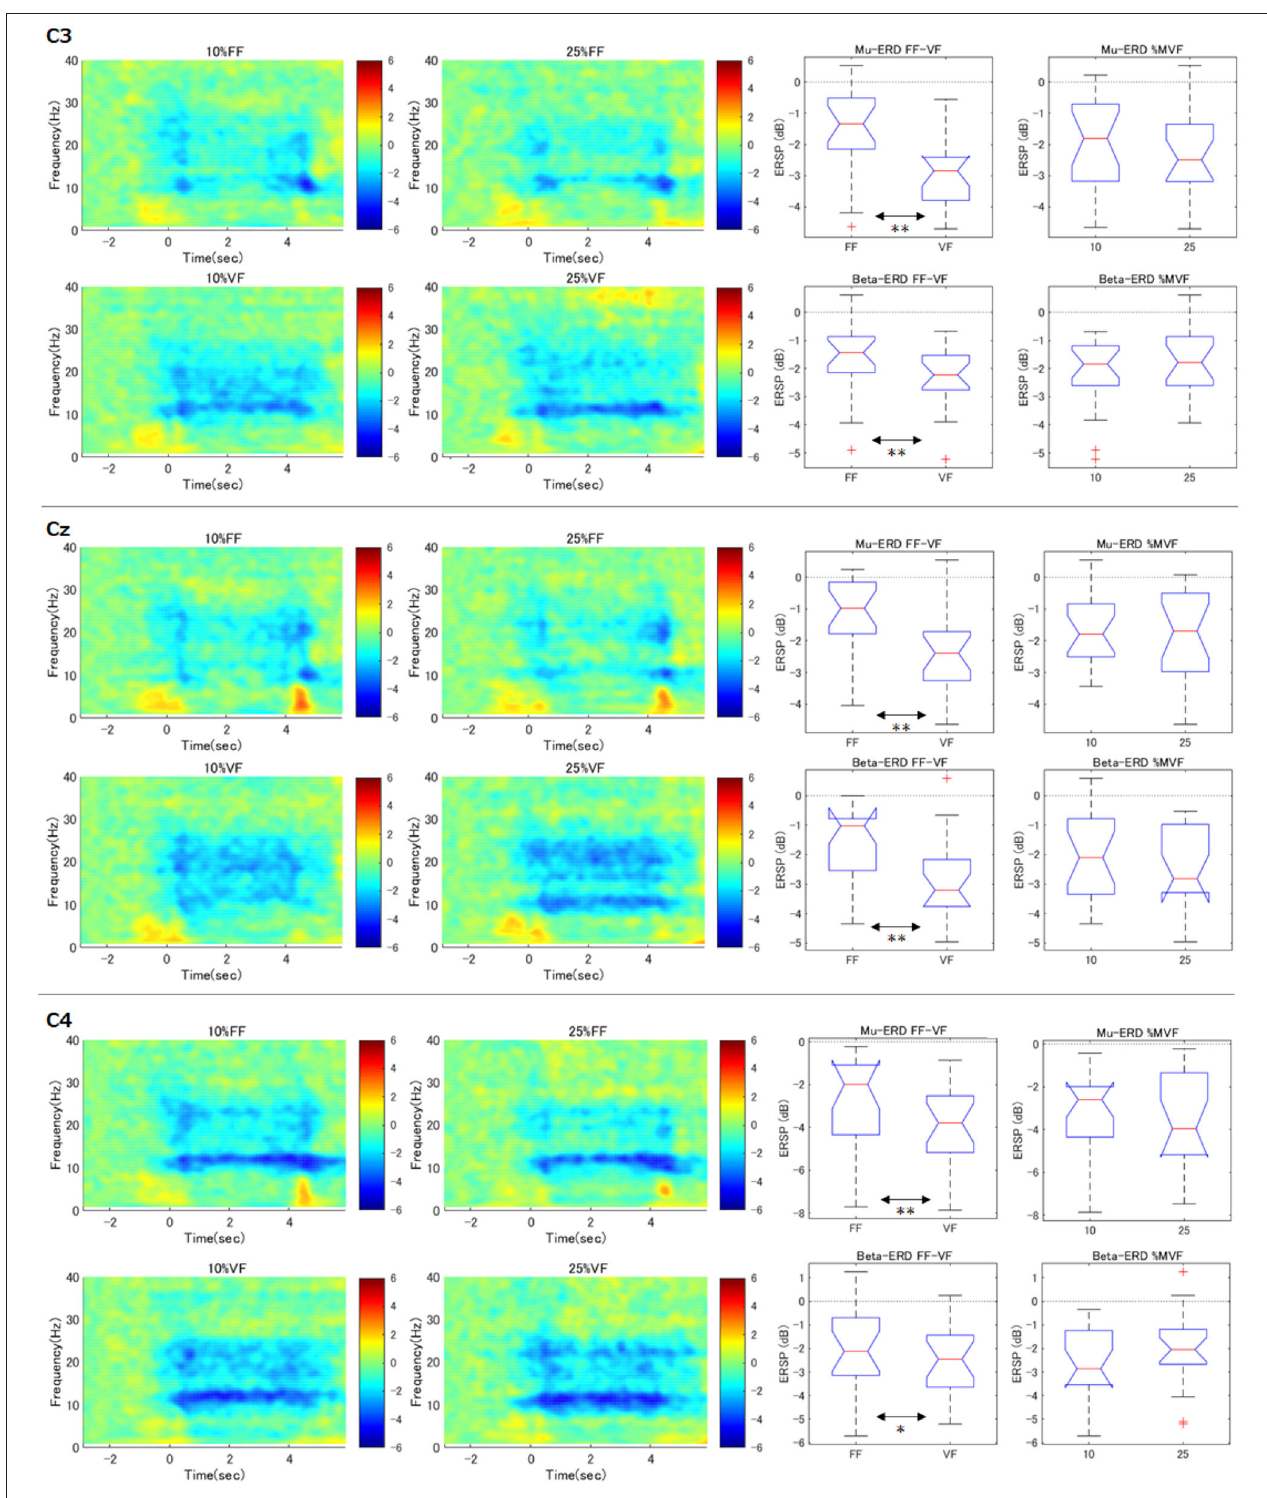
FIGURE 4 | Time-frequency maps of ERD/S and comparison of ERD during maintenance of grasping (C3, Cz, C4). The graphs in the left two columns show the time course of relative power decreases (ERD) and increases (ERS) in the motor cortex under each condition. The horizontal axis is the time aligned with the beginning of the task period (0.0 s), and the vertical axis represents the frequency. The color bar indicates the relative power. In the FF condition, mu-ERD disappeared in the